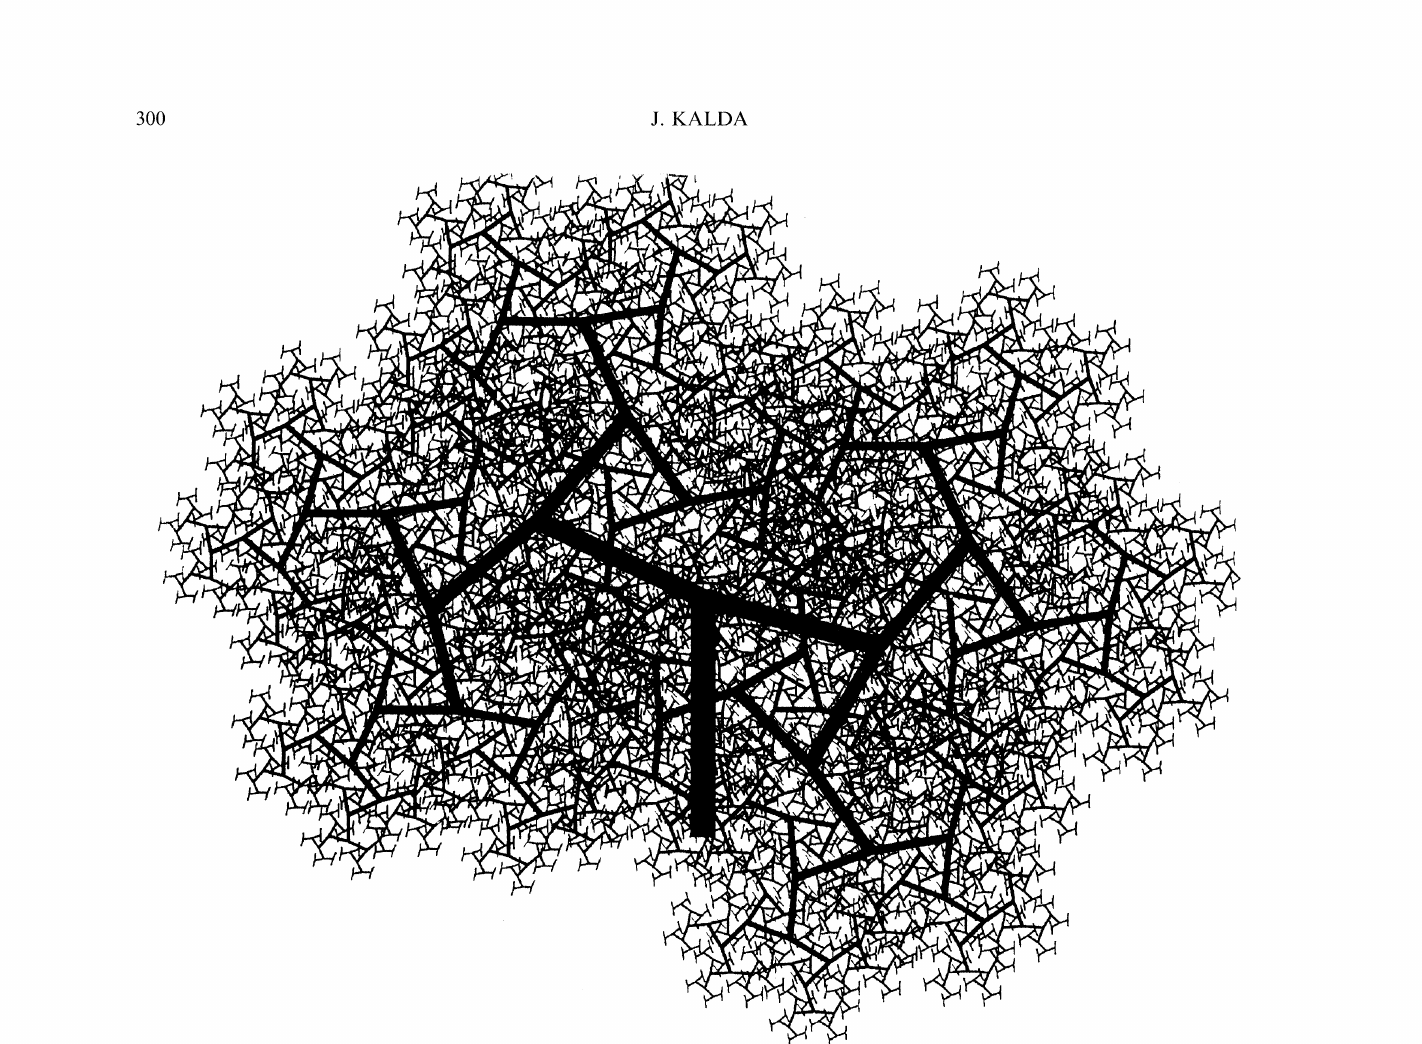
F1GURE Example of a fractal tree with the similarity dimension exceeding the dimensionality of the embedding space: Ds 2.53, D